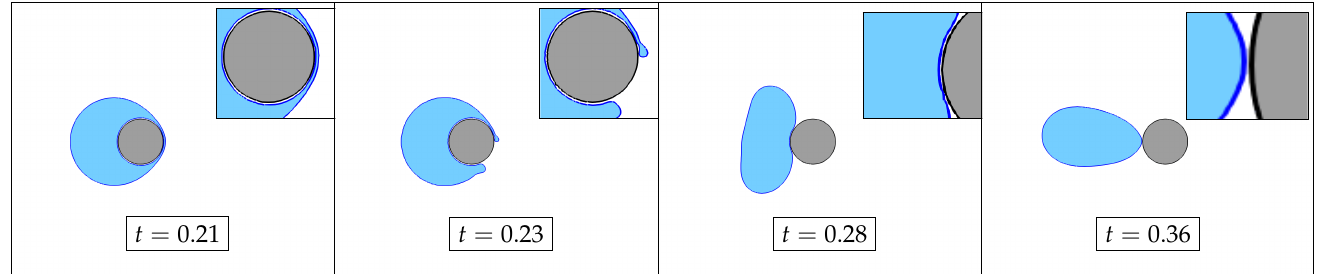
t = 0.21 t = 0.23 t = 0.28 t = 0.36 Figure 13. Motion of a solid cylinder (gray) covered by a fluid shell (blue) in a surrounding fluid (white). There is a lubrication layer with the thickness of δ = 0.05 R s between the fluid 1 and the solid. Left–right periodicity and top–bottom symmetry are assumed as boundary conditions. BPM with the nonlinear correction in Equation (15) is used. The results are shown at different times t . The insets highlight the relative location of the interfaces, where the dark blue indicates the interface of fluid 1 and the black indicates the solid